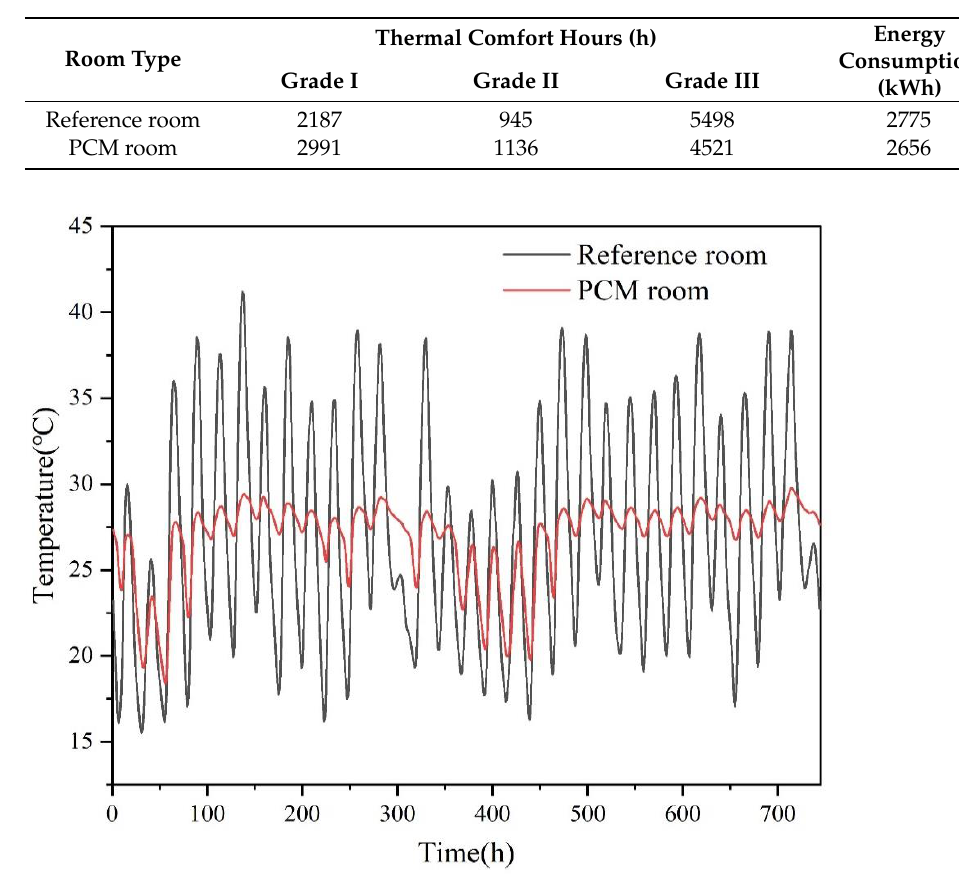
Figure 10. Indoor thermal comfort operative temperature of prefabricated temporary houses in May.